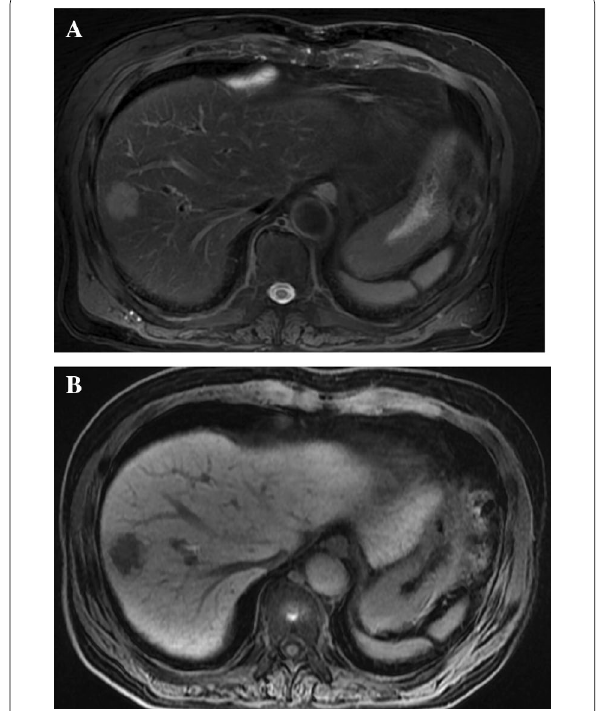
Fig. 3 A , B Gadolinium–ethoxybenzyl-diethylenetriamine penta-acetic acid-enhanced magnetic resonance imaging showing a tumor as a hyperintense lesion without central filling on the T2-weighted image (arrow) and a hypointense lesion in the